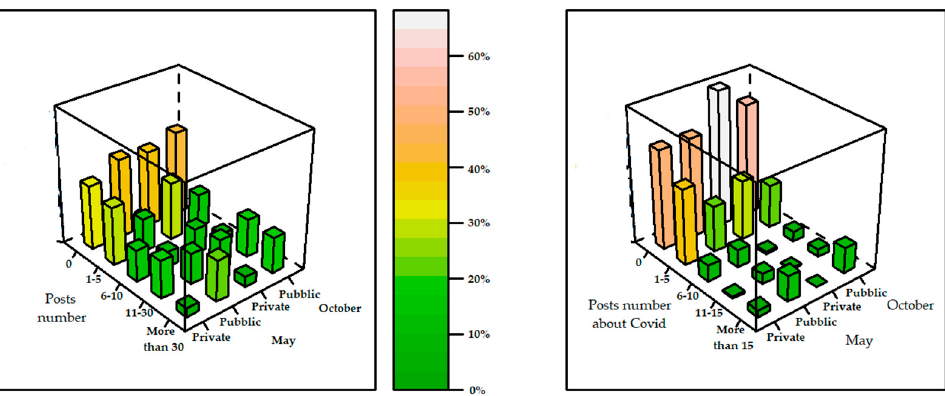
Figure 5. Scatterplot. 3.3. Distribution of Publication Frequency The variable relating to the publication frequency is the average between the differ- ence in days between the last and penultimate posts, and that which was between the